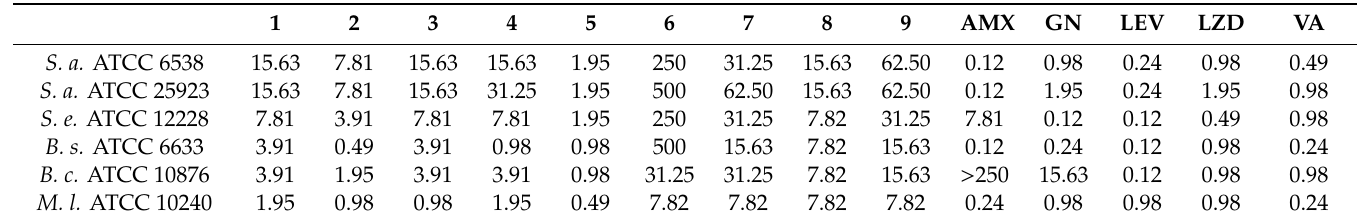
Table 1. Antibacterial data (MIC, µ g / mL) for 4-benzoylthiosemicarbazides 1 – 5 , 4-arylthiosemicarbazides 6 – 9 , and